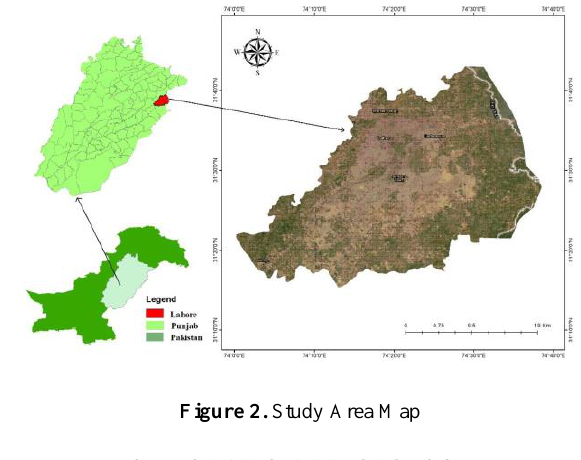
Figure 2. Study Area